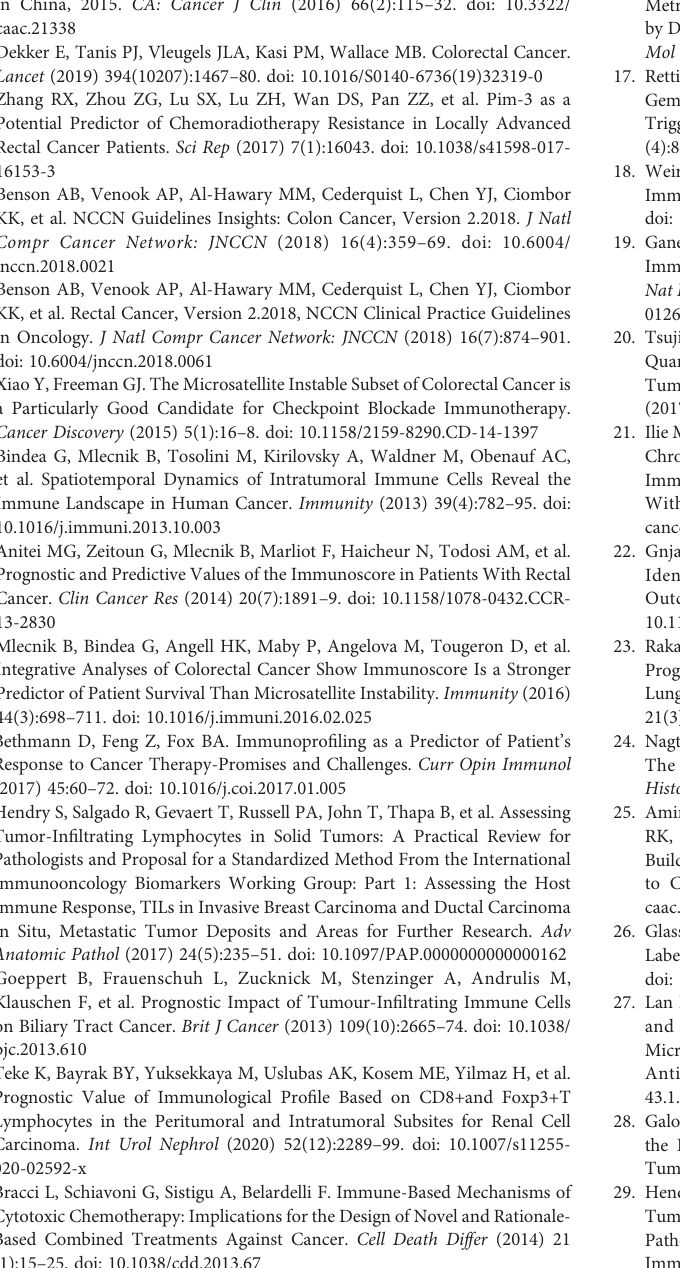
densities of B cells (A) , CD66b + Granulocytes (C) and CD68 + macrophages (E) in the CT region of pMMR CRC treated with neoaduvant chemotherapy (NCT) or not treated with NCT (non-NCT). The violin plots provide statistical comparisons for B cells (B) ,CD66b + Granulocytes (D) andCD68 + macrophages (F) innon-NCT group andNCT group. Thethickdashed linesand thindotted linesdenote the median and interquartile range, respectively. Statistical signi fi cances were determined via Mann- Whitney tests, with * P < 0.05, ** P < 0.01, n.s. not signi fi